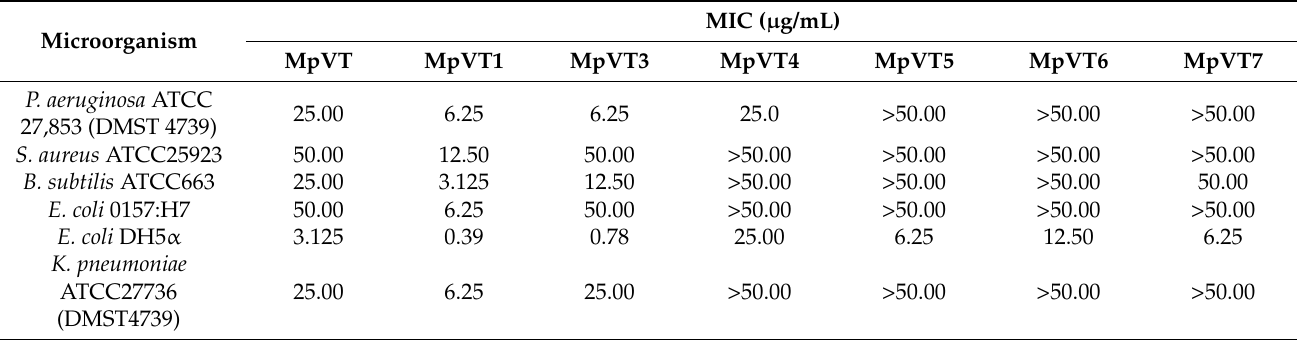
Table 3. Antimicrobial activity and hemolysis activity of MpVT and its